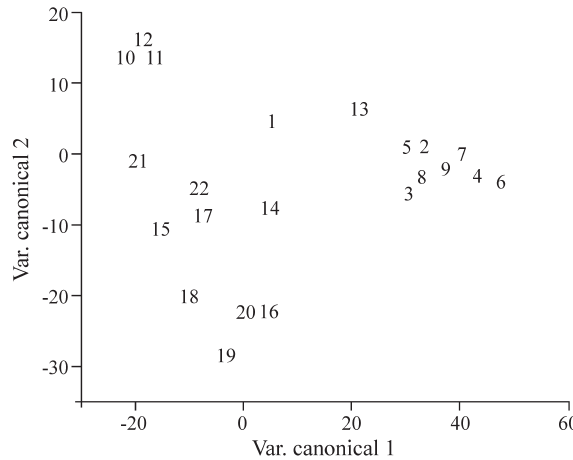
Figure 7 - Graphic dispersion of the scores of the two more important ca- nonical variables for the 21 accessions of Pennisetum spp. of the Active GermplasmBankofEmbrapaGadodeLeite.Thenumerationcorresponds to the accessions: 1. wild 15; 2. wild 12; 3. wild 10; 4. wild 14; 5. wild 9; 6. wild 16; 7. wild 13; 8. wild 17; 9. wild 1; 10. wild 6; 11. wild 4; 12. wild 3; 13. wild 8; 14. BAG 45; 15. Hexaploid 204; 16. Hexaploid 199; 17. F92-167-1; 18. F92-176-1; 19 BAG 65; 20. BAG 46; 21. BAG 103. UFLA. Lavras, MG, Brazil, 1998.